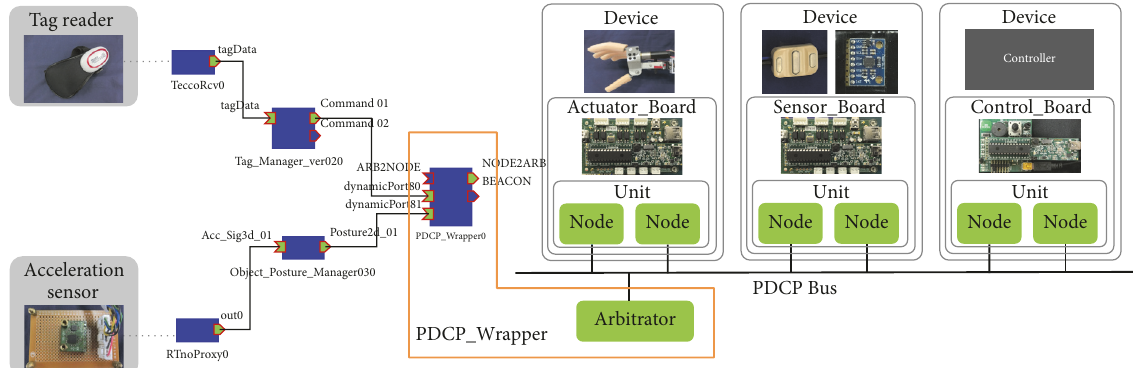
Figure 1: System structure of RTM-PDCP linkage